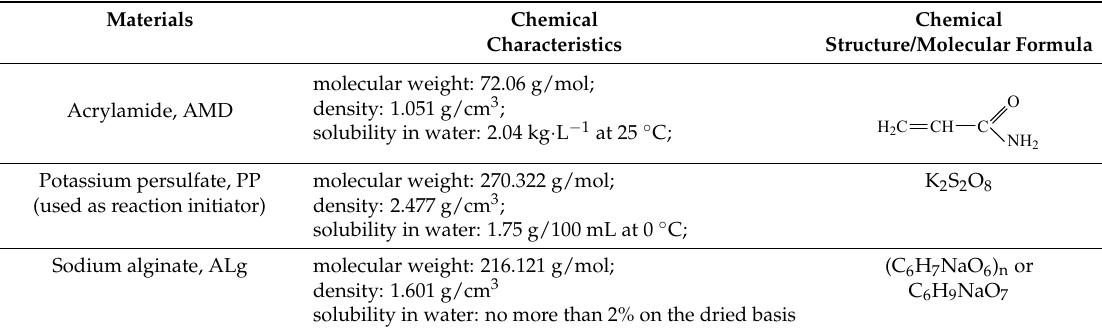
Table 1. The materials used for polyelectrolytes